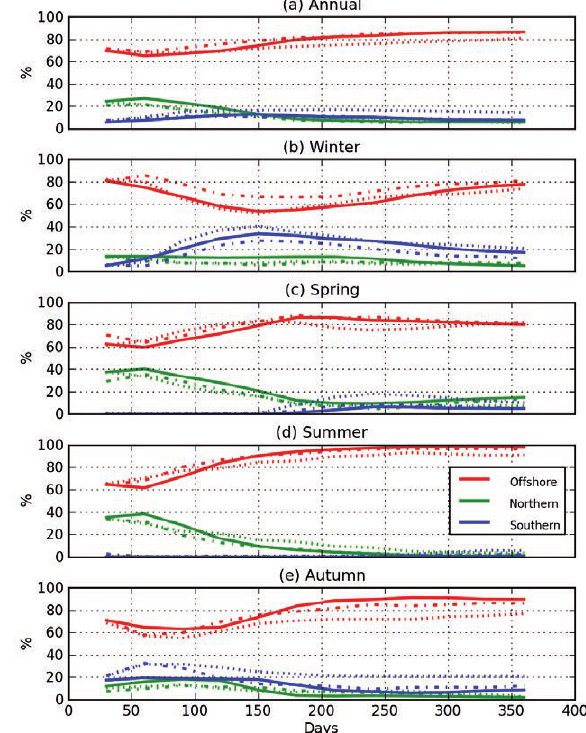
f ig . 6. – Plots comparing the (a) annual and (b-e) seasonal parti- cle percentage contributions from the three pathways (offshore in red, northern in green, southern in blue) that lead to the target area identified in Figure 5, as a function of time from release in days. Full curves correspond to the climatological runs (experiments 1-4), dash-dot and dotted curves correspond to the respective sets of high frequency runs (experiments 5-8 and 9-12). Sample sizes are 47000 floats, for a depth range of 0 - 300 m. A colour version of this figure may be found in the online electronic